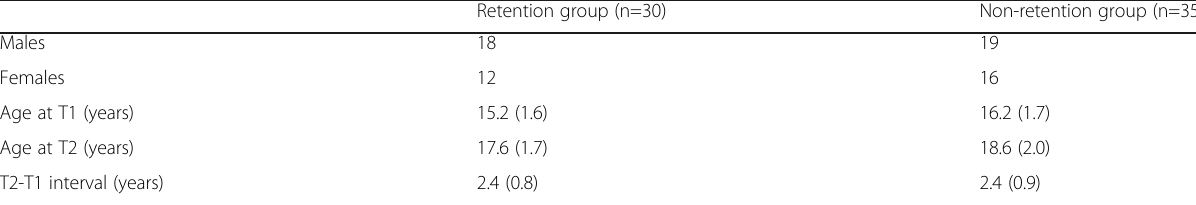
Table 1 Summary statistics (means, SD in parentheses) of the retention and non-retention groups Retention group